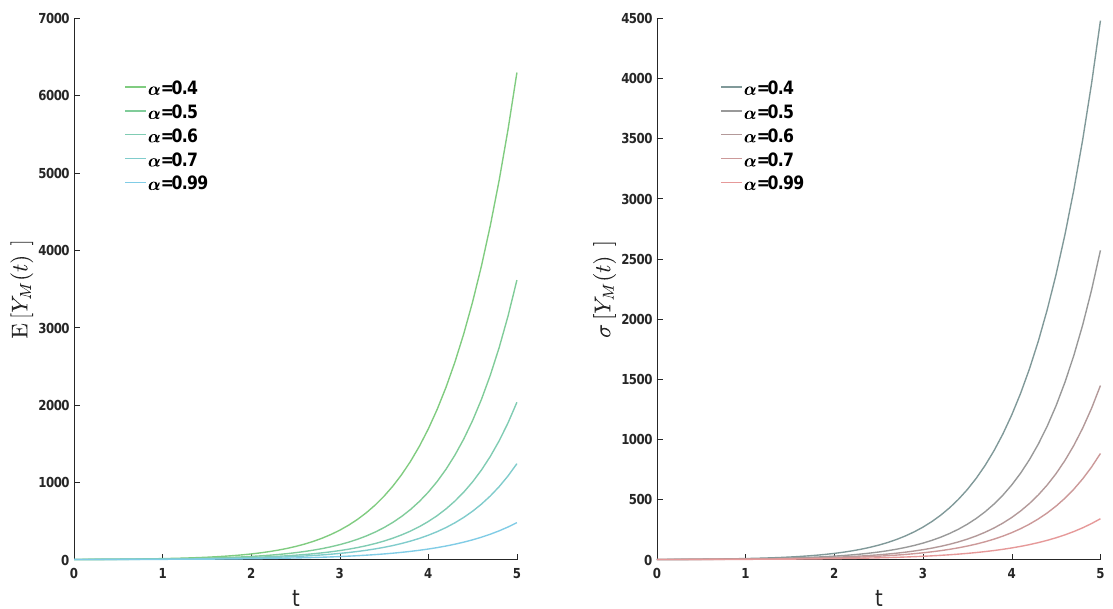
Figure 4 Approximations of the mean (left) and the standard deviation (right) of the solution SP to the random IVP (2) with M = 20, λ = 5 / 4, E [ b 0 ] = E [ c ] = − 1 and V [ b 0 ] = V [ c ] = 1 / 4 using different orders of the derivative α = { 0 . 4 , 0 . 5 , 0 . 6 , 0 . 7 , 0 . 99 } over the time interval [ 0 , 5 ]